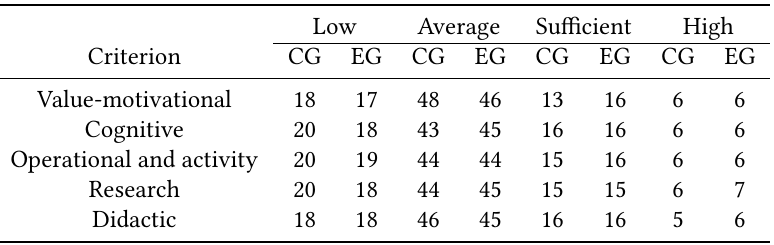
Table 2 Levels of formation of digital competence of CS bachelors in the use of CBLE in control (CG) and experimental (EG) groups (before the